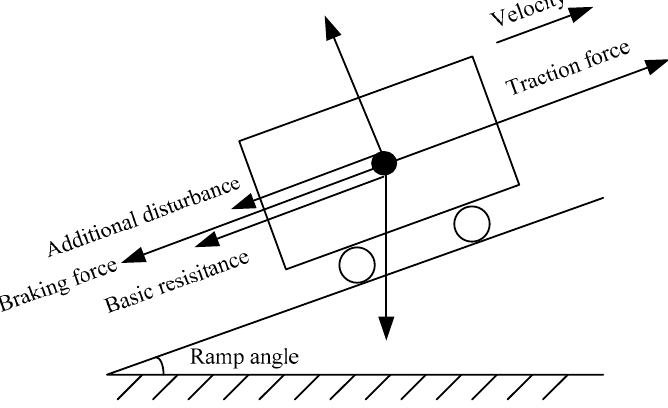
Figure 1. Force diagram of longitudinal train dynamical model.